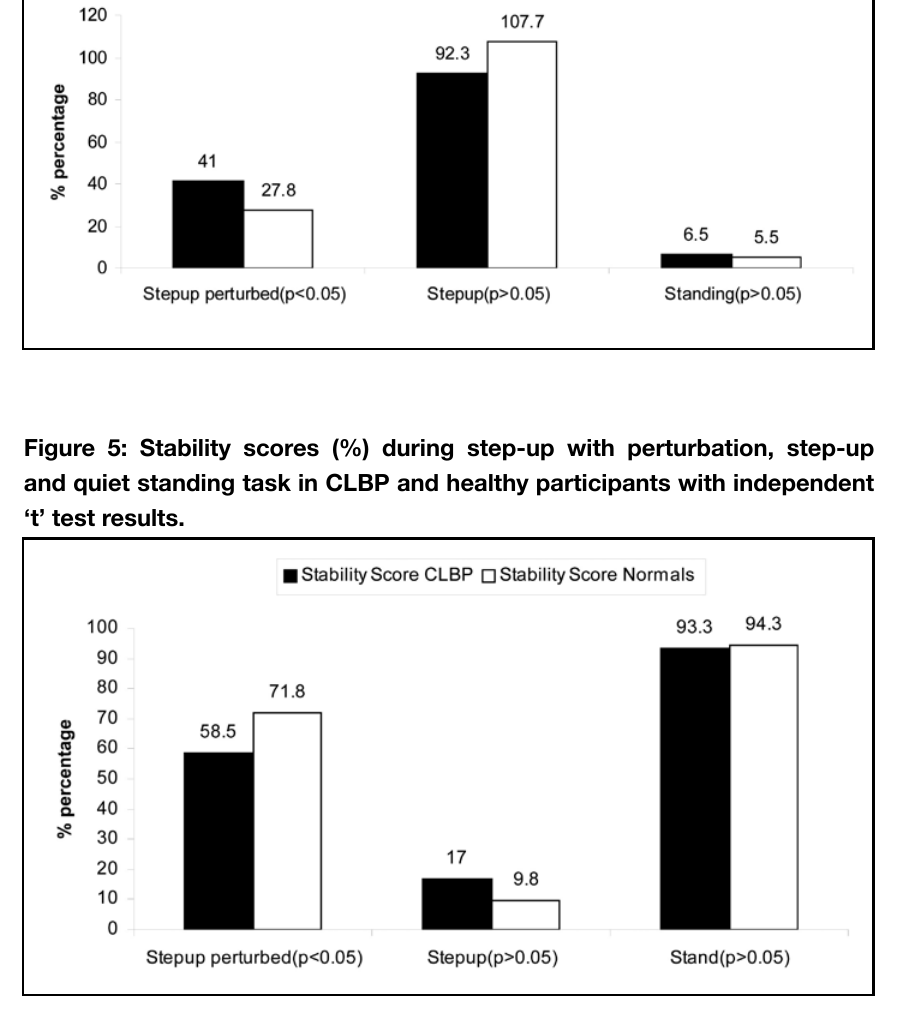
Figure 6: Sub-group analysis of coP (Medio-lateral) excursions during step-up with perturbation, step-up and quiet standing task between movement impairment and control impairment clBP groups with paired ‘t’ test